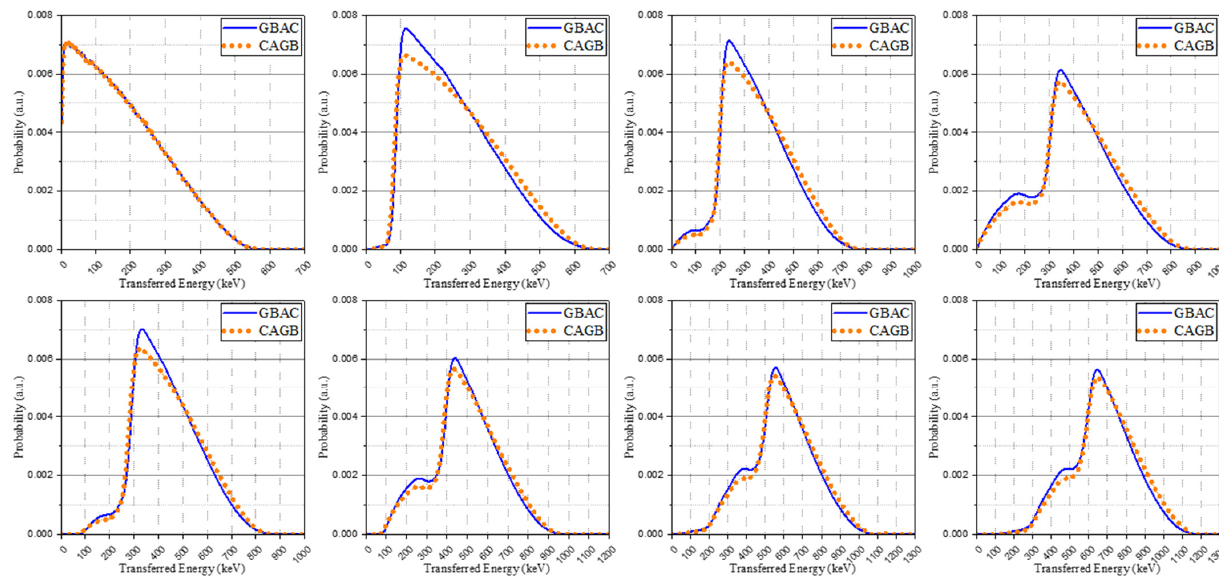
Figure 4. The base spectra obtained by two methods: Gaussian broadening after convolution (GBAC, blue solid line) and convolution after Gaussian broadening (CAGB, orange dot line).